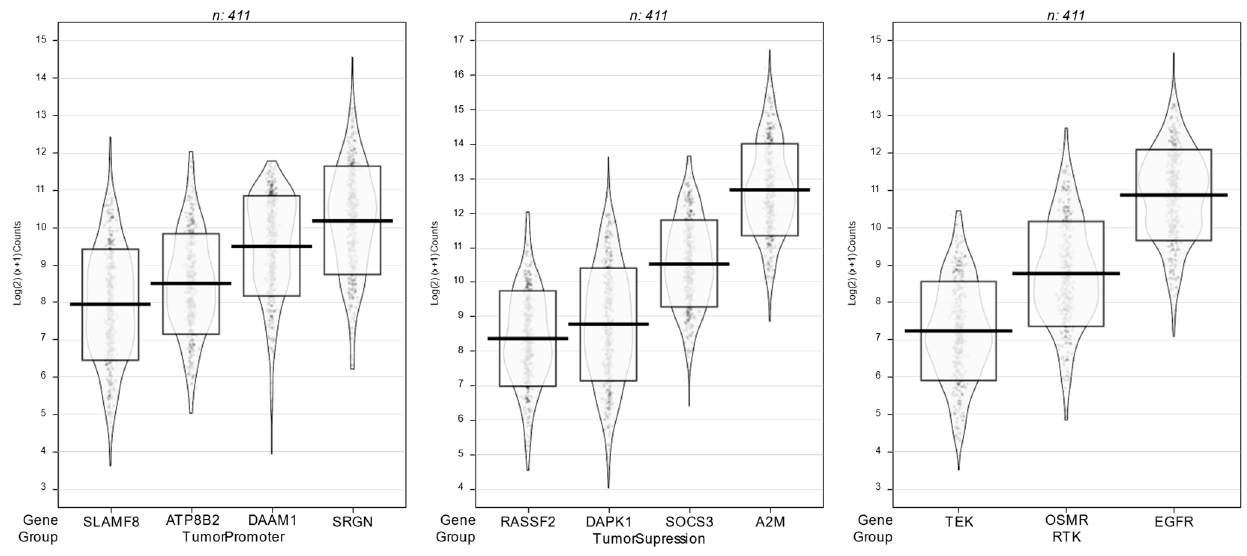
Figure 3. Violin density plots of the expression of EGFR and other inflammation-correlated tumor response genes.